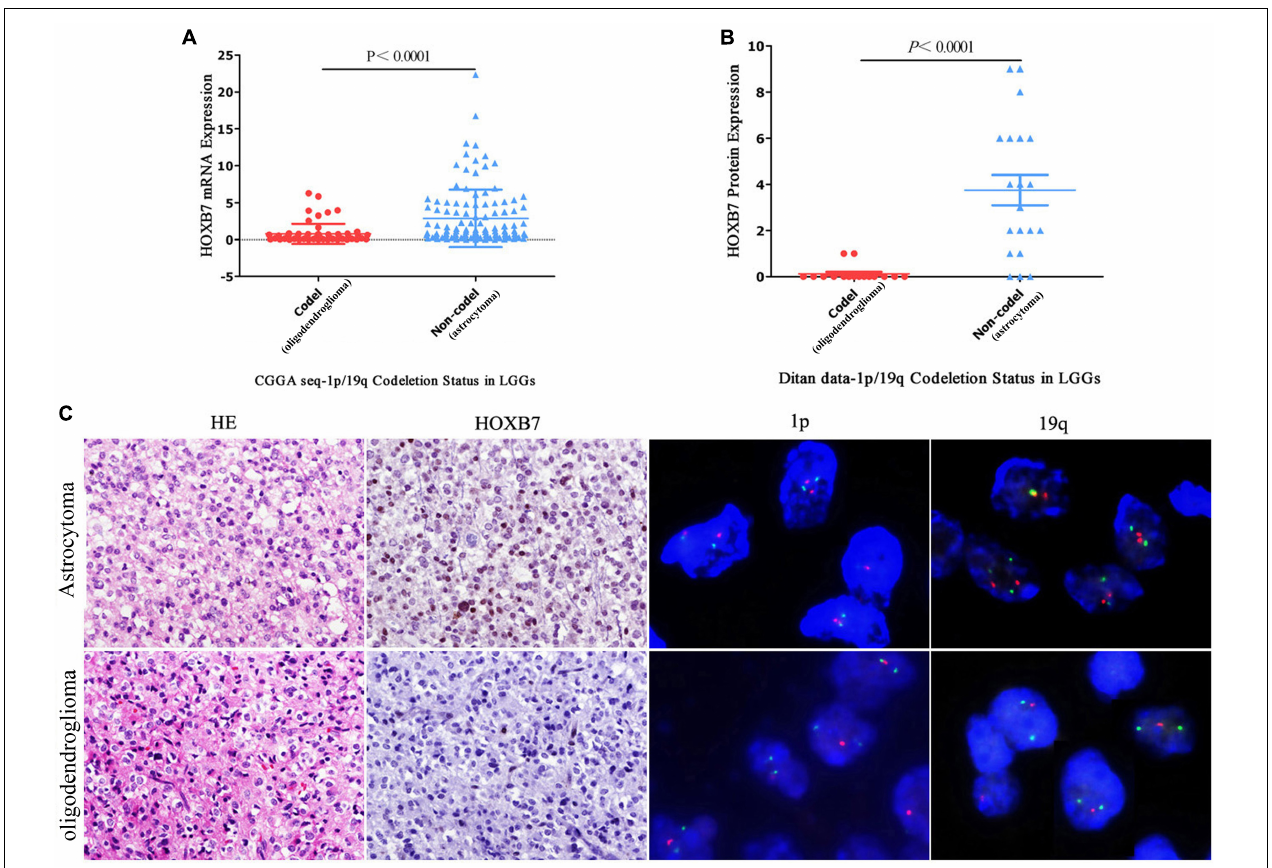
FIGURE 6 | Homeobox B7 expression is related to 1p/19q molecular subtypes in CGGA and in Ditan data sets. The expression of HOXB7 is significantly lower in 1p/19q codeletion gliomas (oligodendroglioma) based on the CGGA data sets (A) and Ditan data sets (B) . Immunohistochemical staining of HOXB7 protein expression according to 1p/19q status showing the loss of HOXB7 protein expression in 1p/19q codeletion anaplastic oligodendroglioma. Only a few nuclei are weakly positive in the background. The other case of anaplastic astrocytoma, 1p/19q non-codeletion, showing the strong nuclear location of HOXB7 protein [ (C) , HE, EnVision, serial sections, Original magnification × 400, FISH, Original magnification ×